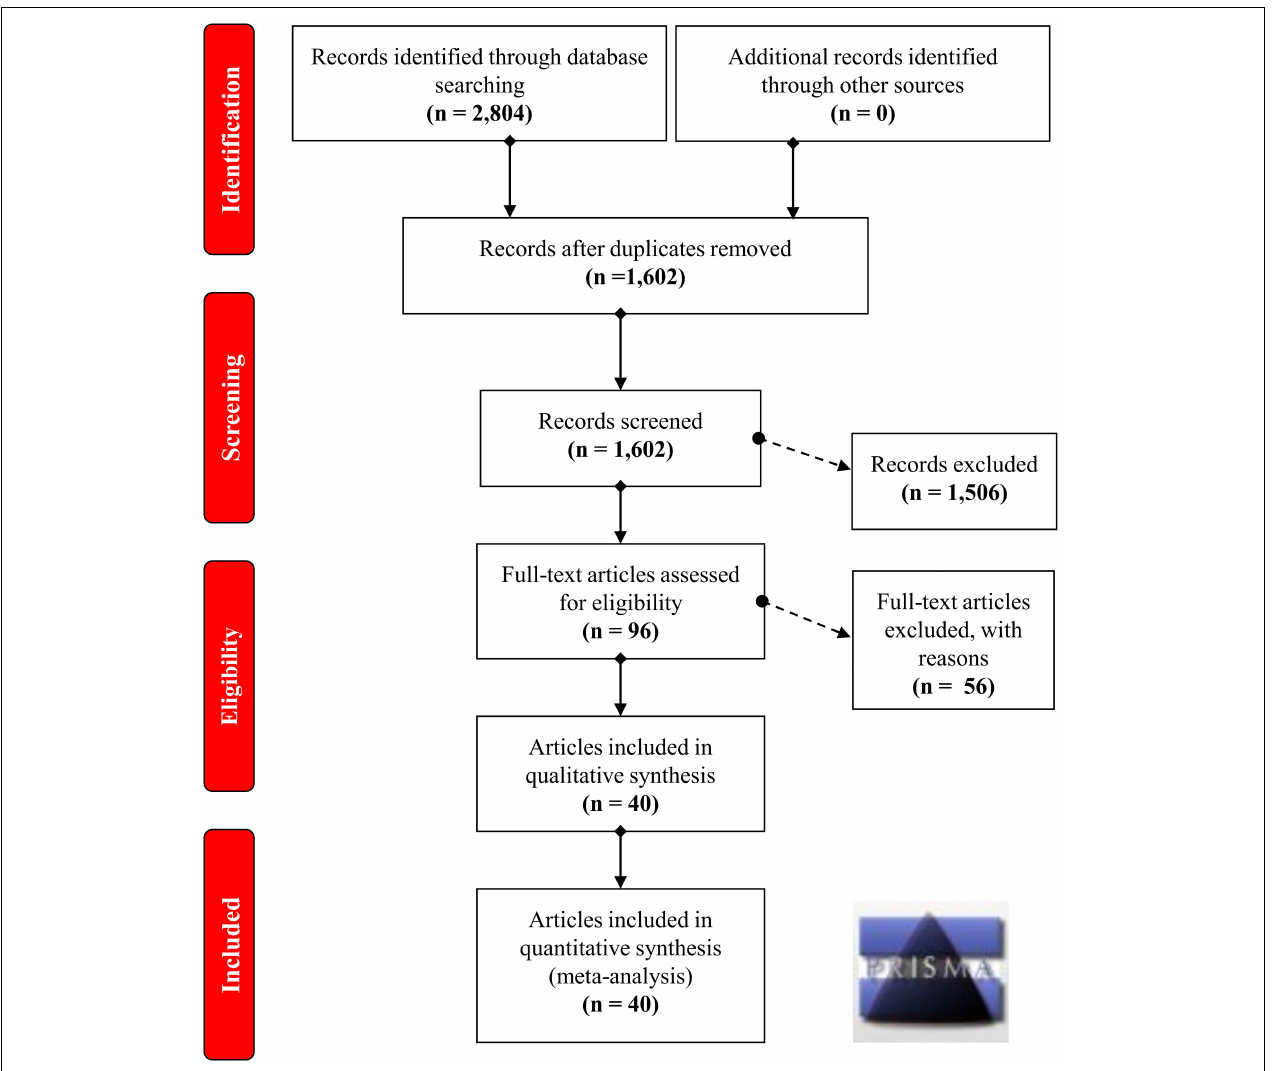
FIGURE 1 | Selection process for eligible case-control